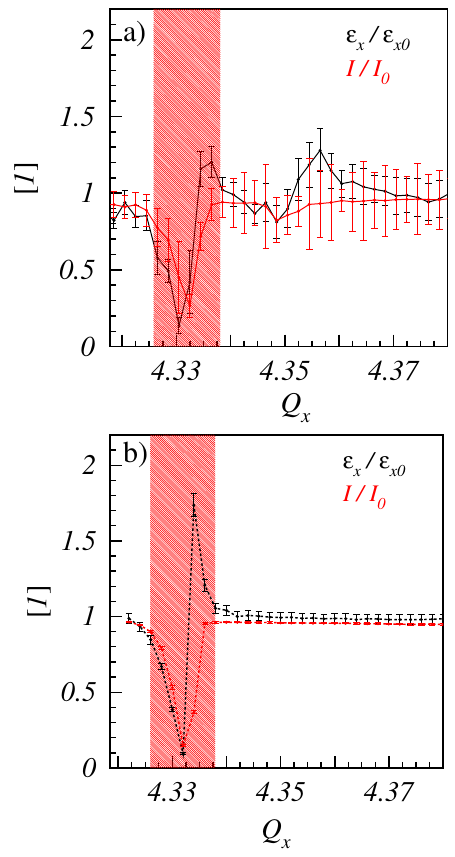
FIG. 6. Low intensity coasting beam: (a) Measured normalized emittance increase and beam loss versus Q x . (b) Simulation of beam loss and emittance increase: The stop band of beam loss allows the calibration of the strength of the nonlinearities in the lattice